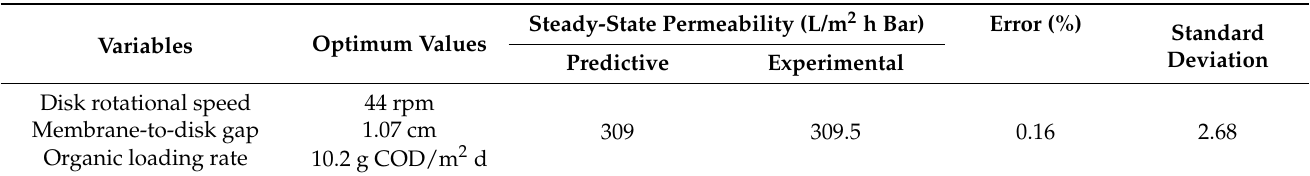
Table 5. Optimized operational parameter values at maximum permeability.